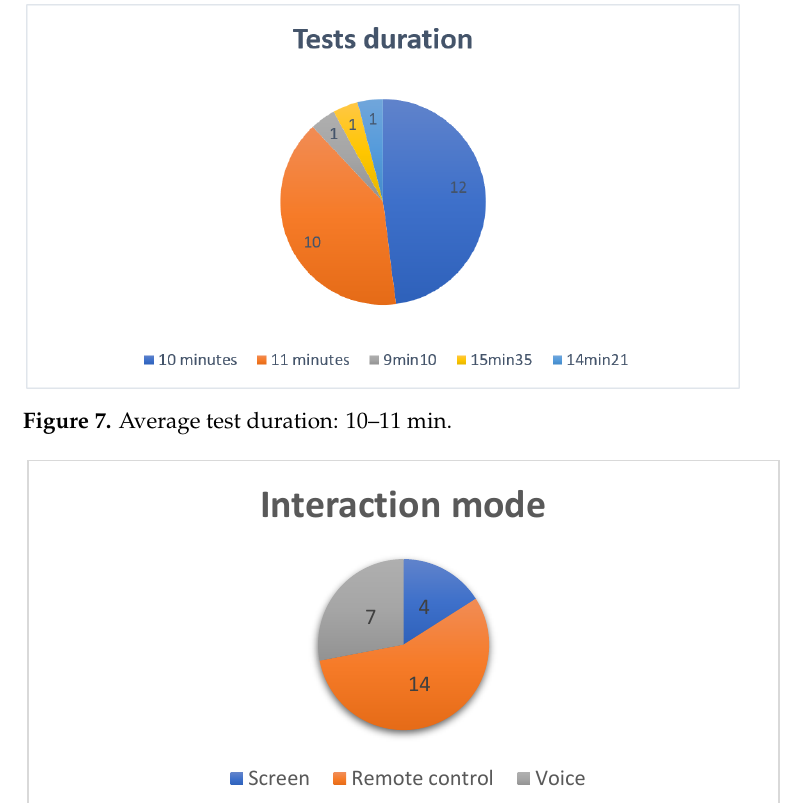
Figure 6. Evaluation scores of interaction aspects (out of /5).